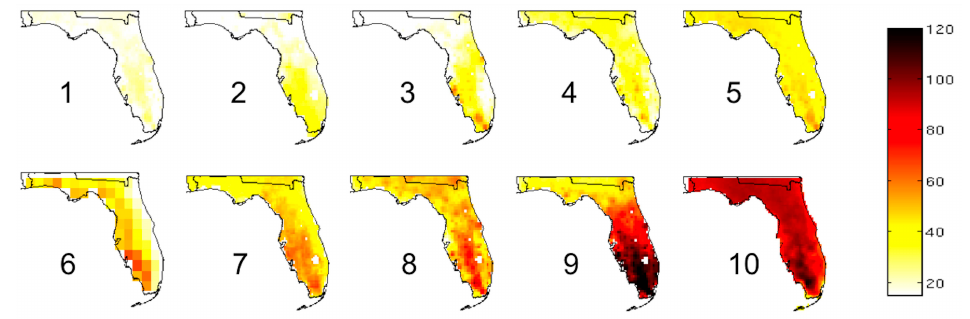
Figure 4. Mean change in annual number of days with a maximum temperature exceeding 35 °C (95 °F) projected between 2039–2070 and 1969–2000 for each of the 10 models used in the Florida case studies (see Table 1), arranged from least to greatest change.